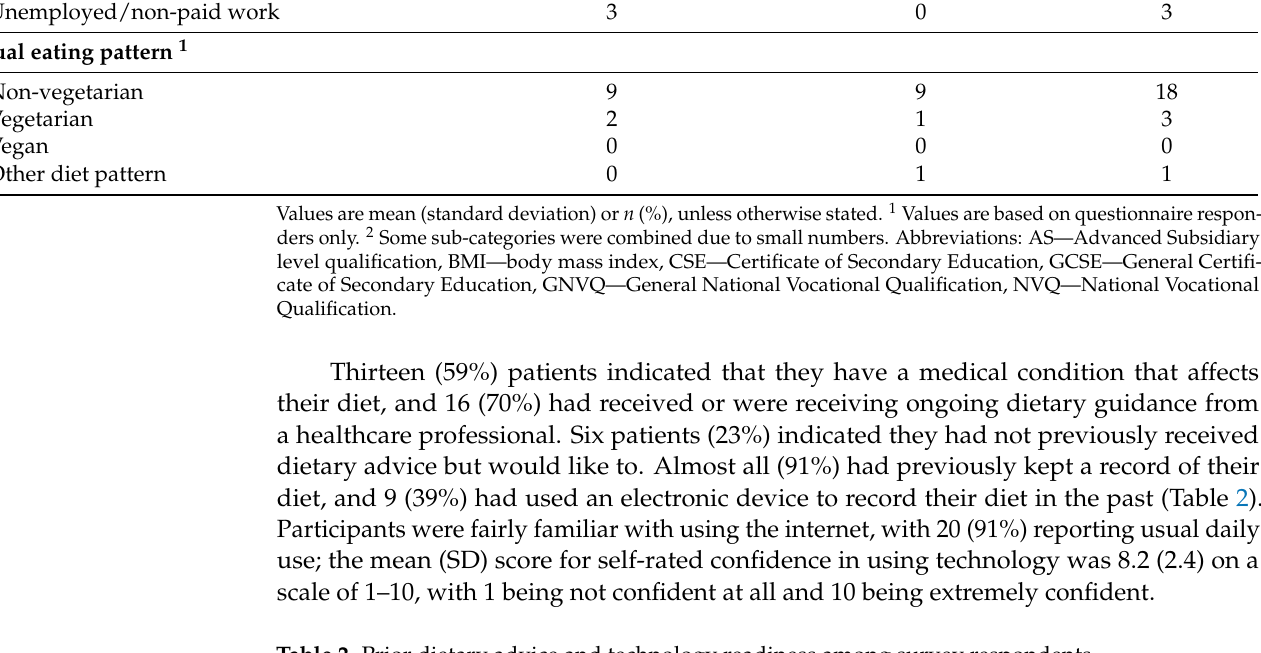
Table 2. Prior dietary advice and technology readiness among survey